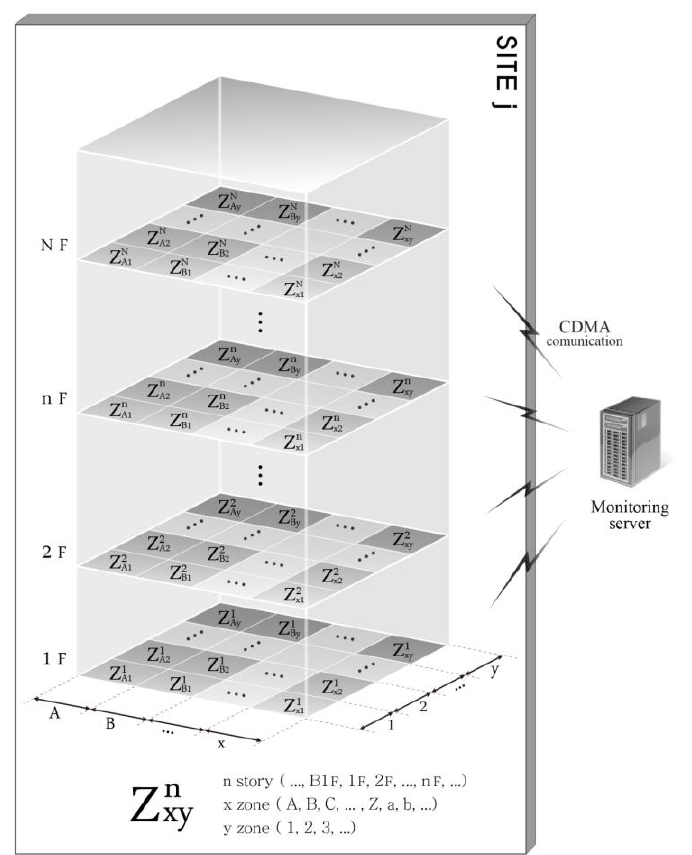
Figure 3. Vertical zoning in the site of an SHM